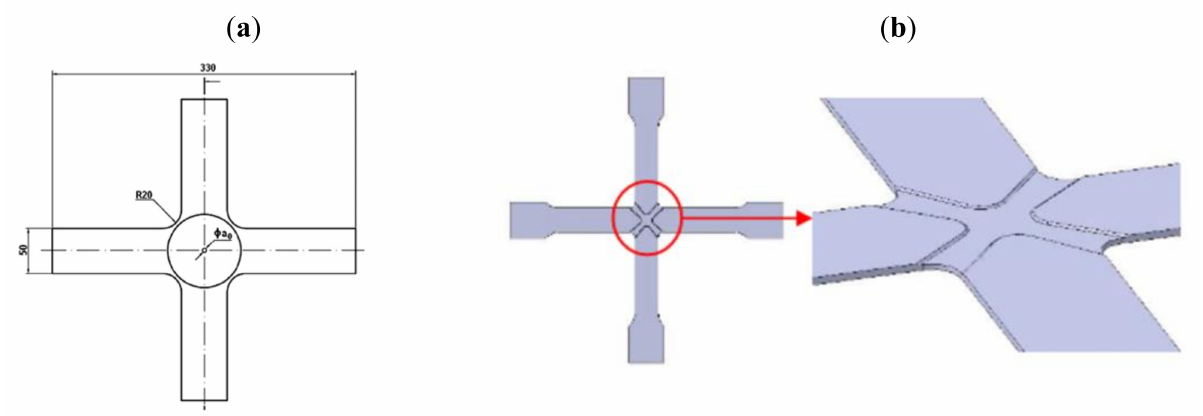
Figure 4. Samples from the literature that were the basis for the specimen geometry: ( a ) with a circular milling area, ( b ) with a cruciform milling